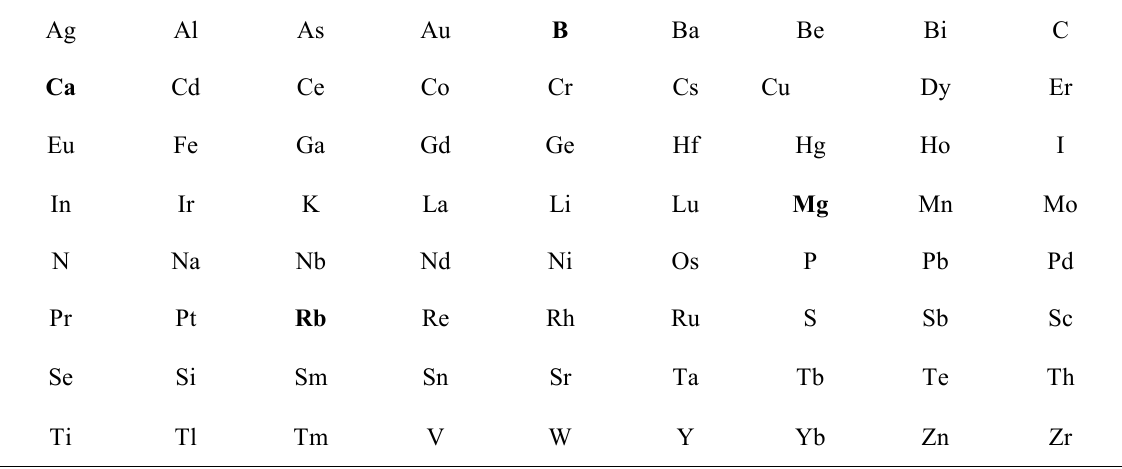
Table 1A: List of 72 elements analysed by Inductively Couple Plasma Spectroscopy.